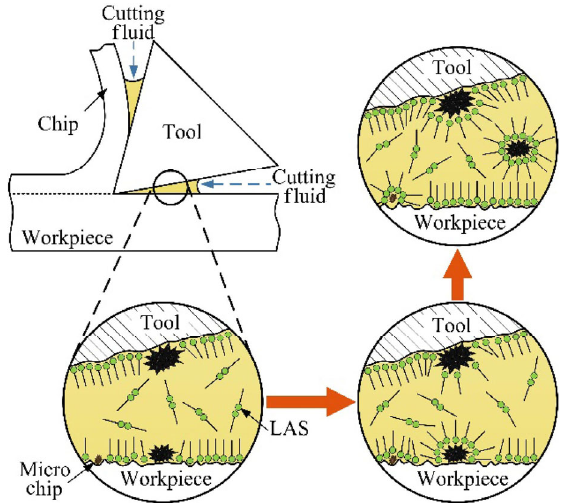
Fig. 14 Cleaning mechanism of micro-cutting chips on the cutting edge of broaching tool.